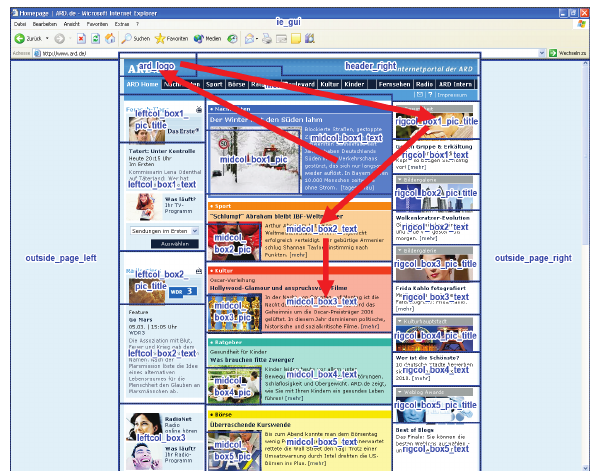
Figure 12. Unique ARD pattern involving a fixed element (ARD logo) and shifting between columns, occurring in 5 out of 10 presentations, initially in presentation 2 (participant 2)